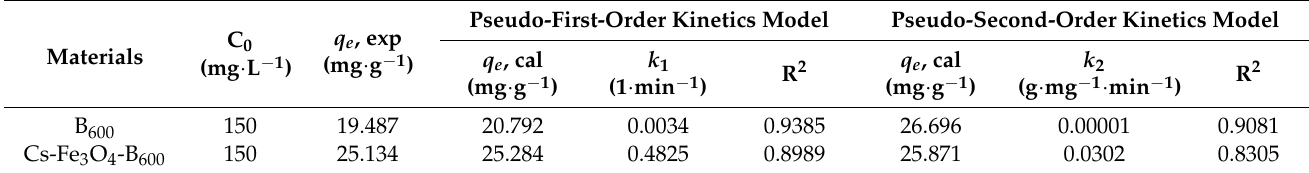
Figure 3. Fitting of kinetics of Cd(II) on B 600 ( a ) and Cs-Fe 3 O 4 -B 600 ( b ) and isotherm fitting of Cd(II) on Cs-Fe 3 O 4 -B 600 ( c ). Table 1. Pseudo-first-order and pseudo-second-order kinetics models for Cd(II) adsorption on B 600 and Cs-Fe 3 O 4 -B 600